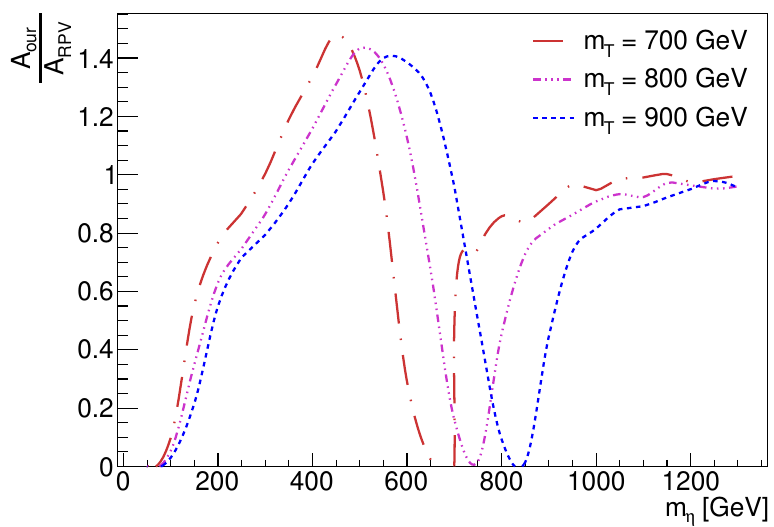
Figure 3. The ratio of acceptance in the recasted CMS search [49] for our model over the RPV benchmark model as a function of the scalar mass for a few top partner